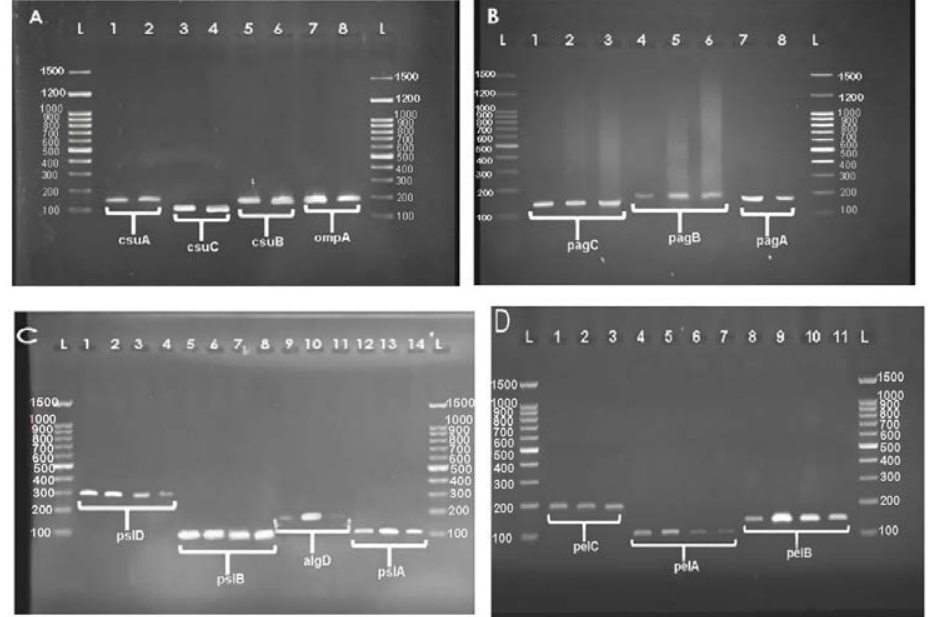
Fig. 4. The amplification and gel electrophoresis agarose 1.5% of biofilm operons of A. baumannii (A and B) and P. aeruginosa (C and D). A: csuA with 156bp (well 1 and 2), csuB with 187bp (well 5, 6), csuC with 109bp (well 3 and 4) and ompA with 182 (well 7 and 8) genes in clinical isolates of A. baumannii, B: pgaA with 186bp (well 7 and 8), pgaB with 190bp (well 4 to 6), and pgaC with 132bp (well 1 to 3) genes in A. baumannii. C: pslD with 295bp (well 1 to 4), pslB with 93bp (well 5 to 8), algD with 126bp and (well 9 to 11), and pslA with 119bp (well 12 to 14) genes in of P. aeruginosa isolates. D: pelC with 192bp (well 1 and 3), pelA with 113bp (well 4 to 7), and pelB with 150bp (well 8 to 11) genes.L: Ladder